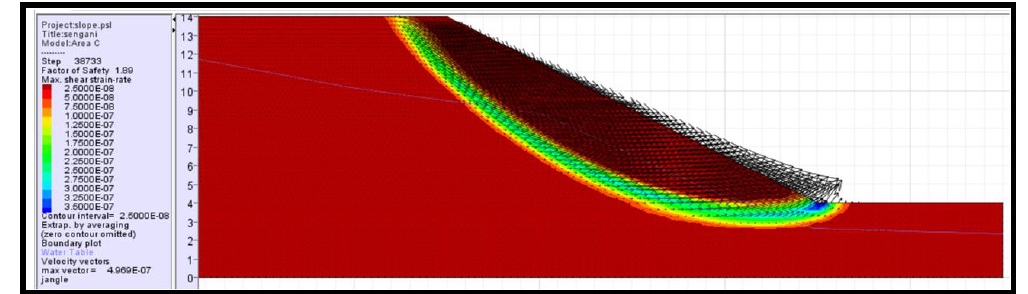
25 of 33 Figure 30. Safety factor simulated for drained to undrained conditions in clay loam soil slope using ( a ) the Lower Karafiath method and ( b ) the Gle/Morgenstern Price method. Simulations of the FoS Using FLACSlope (FDM) Model under Sunny to Rainy Conditions in Clay Loam Soil Slope Results show that slope was stable in sunny conditions (see Figures 31 – 34 and Table 7), meanwhile the stability of the slope gradually reduced with the increase in the water table. The simulation in Figure 33 suggests that the selected slope is prone to failure provided it is exposed to extreme rainfalls. It is arguable that the gradual drop on FoS is relative to the increase in pore water pressure, and as already indicated, the failure observed in the study area has been noted to occur when soil phases changes due to extreme rainfalls. Therefore, one can draw an overall conclusion that the extreme rainfall is indeed one of the common triggering factors of slope instability. Table 7. General results of FLACSlope simulations in clay soil slope. Factor of Safety